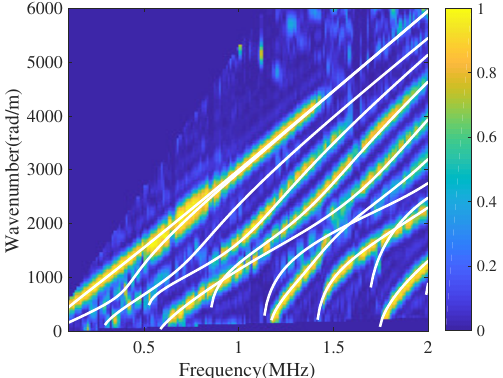
Table 1. The wavenumbers of the shear waves that had larger effects on the theoretical curve than the longitudinal wave at the center frequency (1.0 MHz) of the copper plate and the bone-mimicking plate were 2780 rad/m and 3879 rad/m, respectively. When compared with the wavenumber of the shear wave, the RMSE was less than 4%.